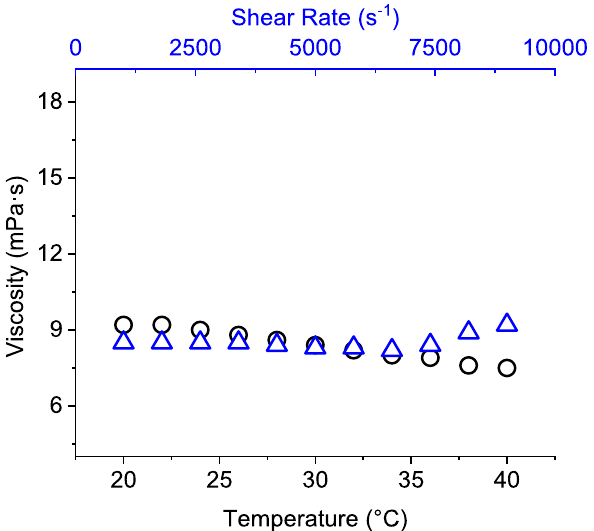
Figure 4. Effect of temperature (O) and shear rate (∆) on the viscosity of carboxymethyl cellulose based